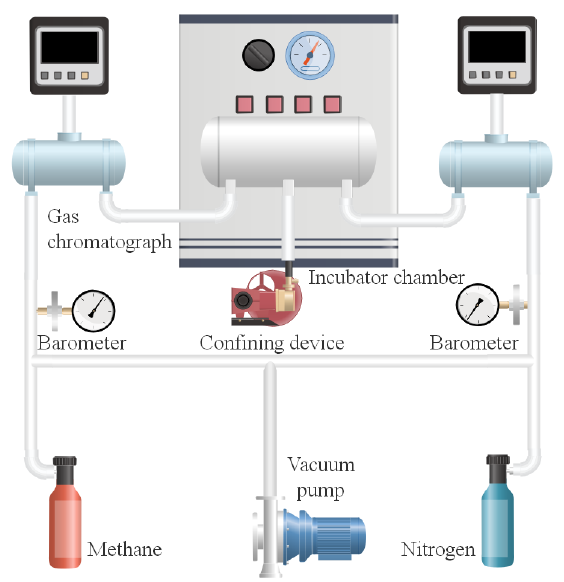
ff usion experiment